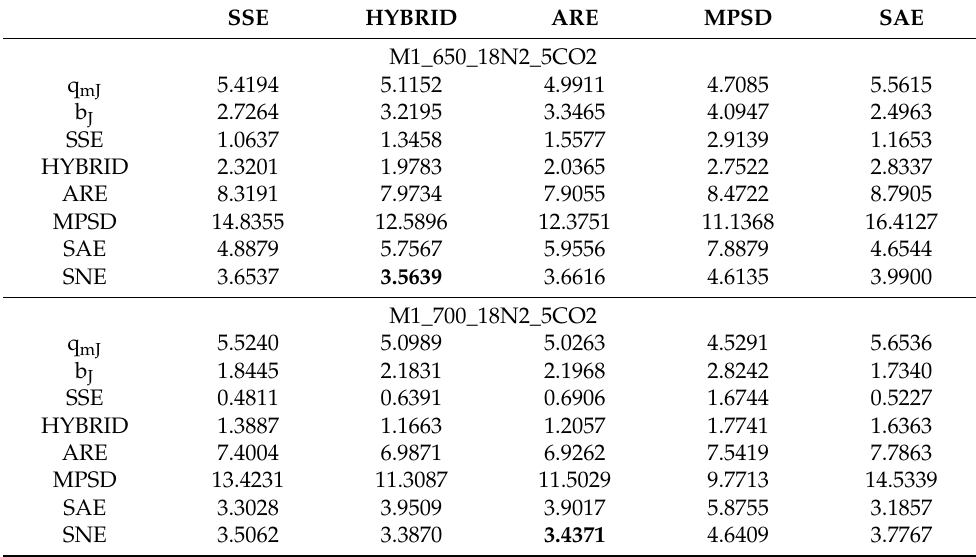
Table 11. Jovanovich isotherms constants with error analysis